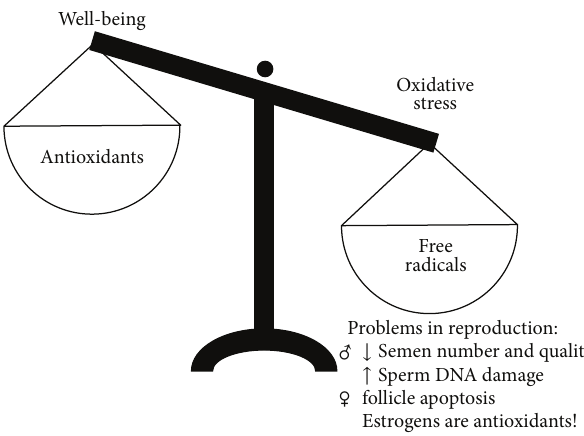
Figure 3: Stress at cellular level: an unbalance between production of free radicals (e.g., reactive oxygen species (ROS)) and antioxidant defenses inducing oxidative stress in the cells. Although oxidative stress is widely accepted as an important pathogenic mechanism in different diseases, yet ROS are physiological mediators of transcrip- tion control and in many cells (e.g., leukocytes) ROS are protection factors against infectious stimuli. The complete elimination of free radicals would thus disrupt, rather than extend, the normal functioning of the